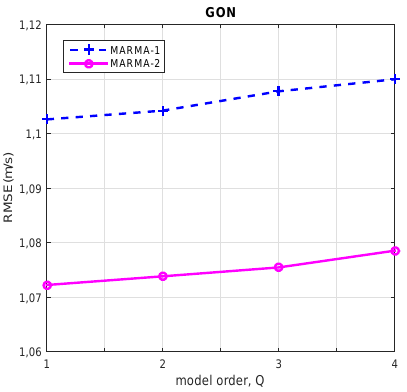
Figure 8. RMSE performances of the MARMA-1 and MARMA-2 models with respect to model order Q when m = 3 (GONEN) and ∆ = 2 h.